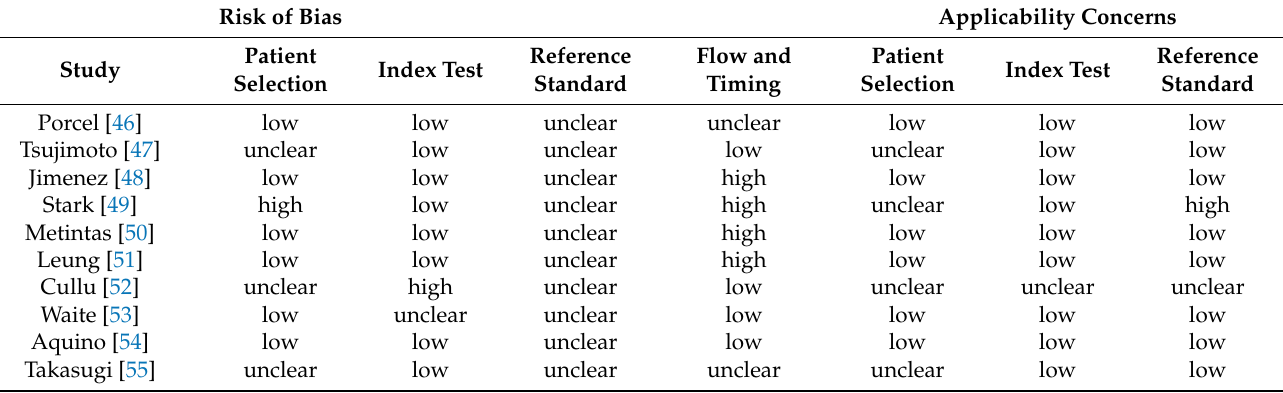
Table 2. Evaluation according to the QUADAS-2 criteria.